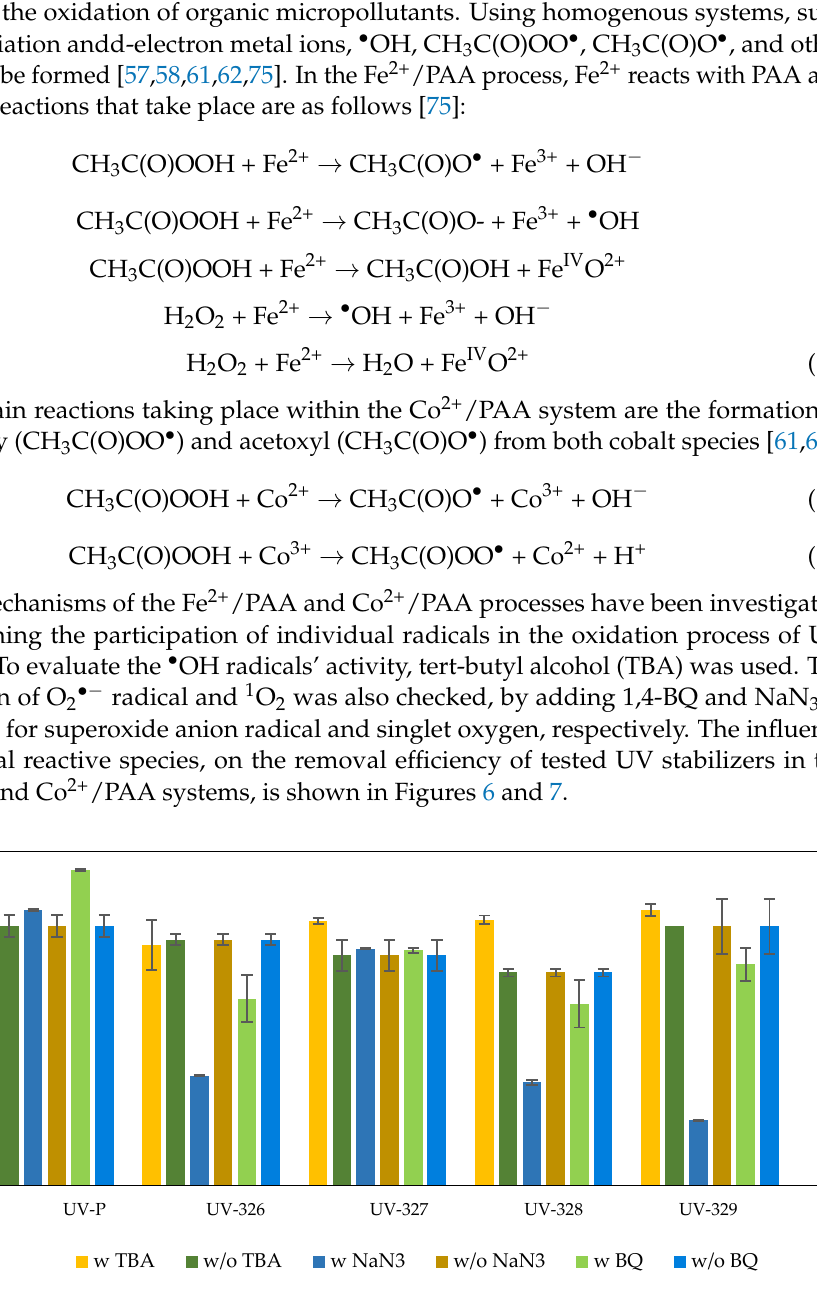
Figure 6. Effect of radical scavengers on UV stabilizers’ degradation in the Fe 2+ /PAA process (w”—reaction with radical quencher, w/o”—reaction without radical quencher).